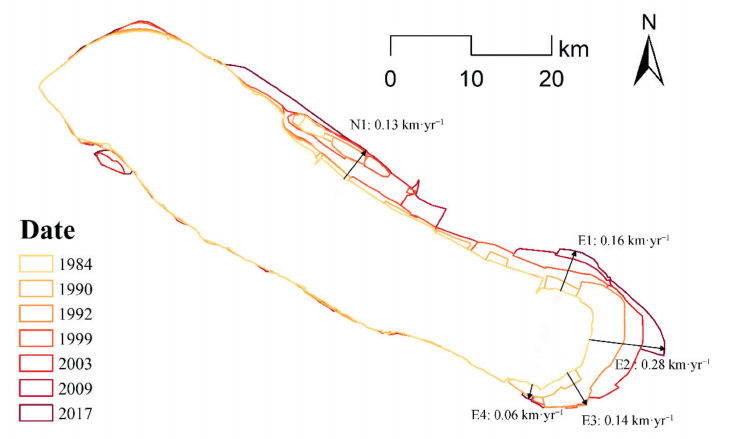
Figure 8. Cofferdam engineering of Chongming Island from 1984 to 2020 (E1, E2, E3, E4, and N represent the direction of cofferdam protection on Chongming